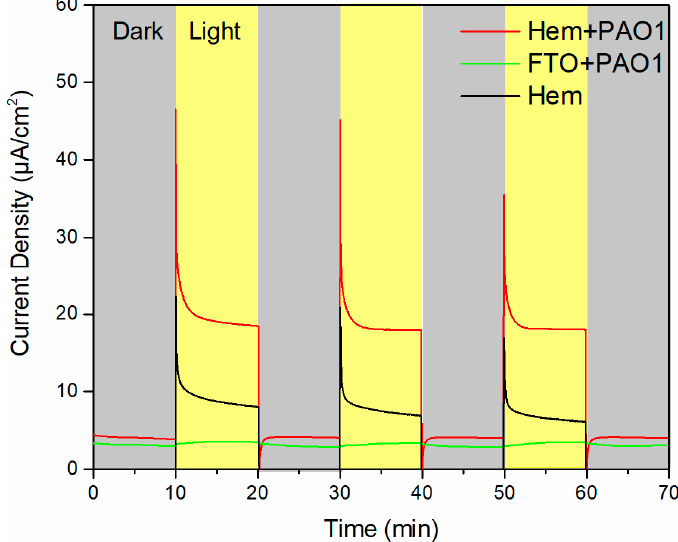
Figure 5. Amperometric I–t curves of the light-hematite-PAO1 system with different conditions under light on/off cycles.